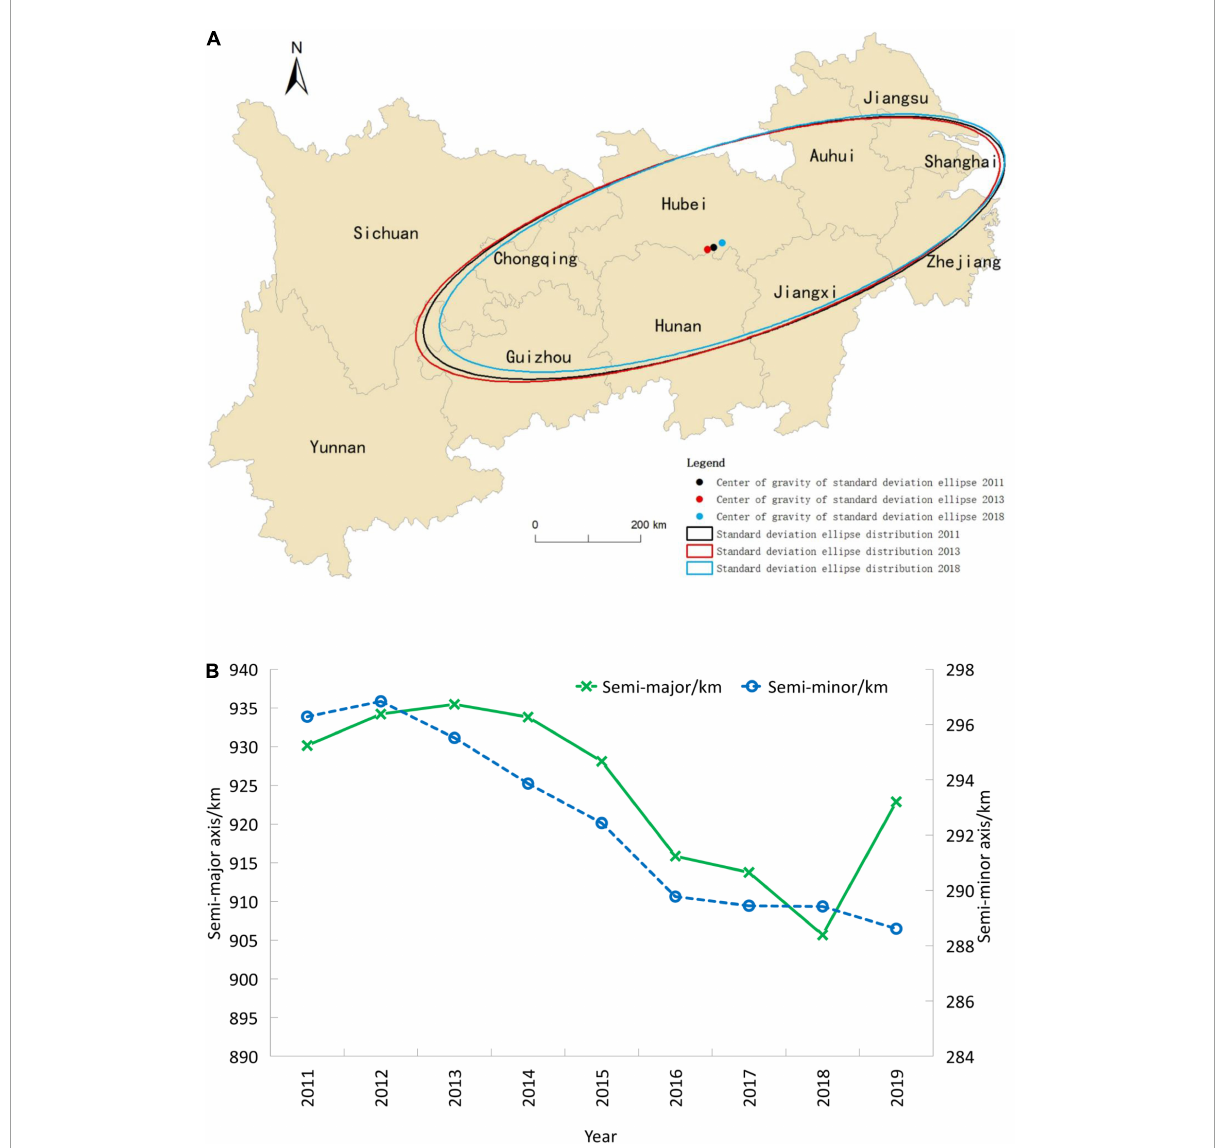
FIGURE2 Distribution of standard deviational ellipse of input–output efficiency of WEF nexus. (A) Standard deviation ellipse distribution of 2011, 2013, and 2018. (B) Variation of semi-major and semi-minor axes of standard deviational ellipse from 2011 to 2019.